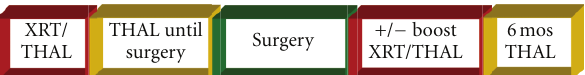
Figure 2: Treatment schema for RTOG 0330 cohort B. Neoadjuvant concurrent thalidomide (THAL) and radiation therapy (XRT) (stop THAL one week prior to surgery), followed by surgical resection, followed by adjuvant THAL for 6 months (post-op boost XRT if a positive margin).